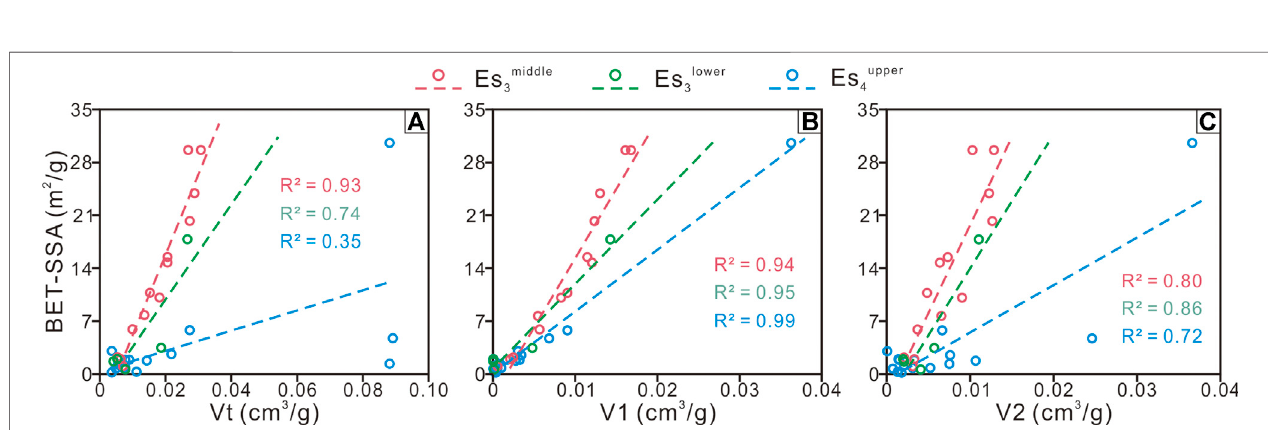
FIGURE 6 | (A) relationships between BET-SSA and Vt; (B) relationships between BET-SSA and V1; (C) relationships between BET-SSA and V2.